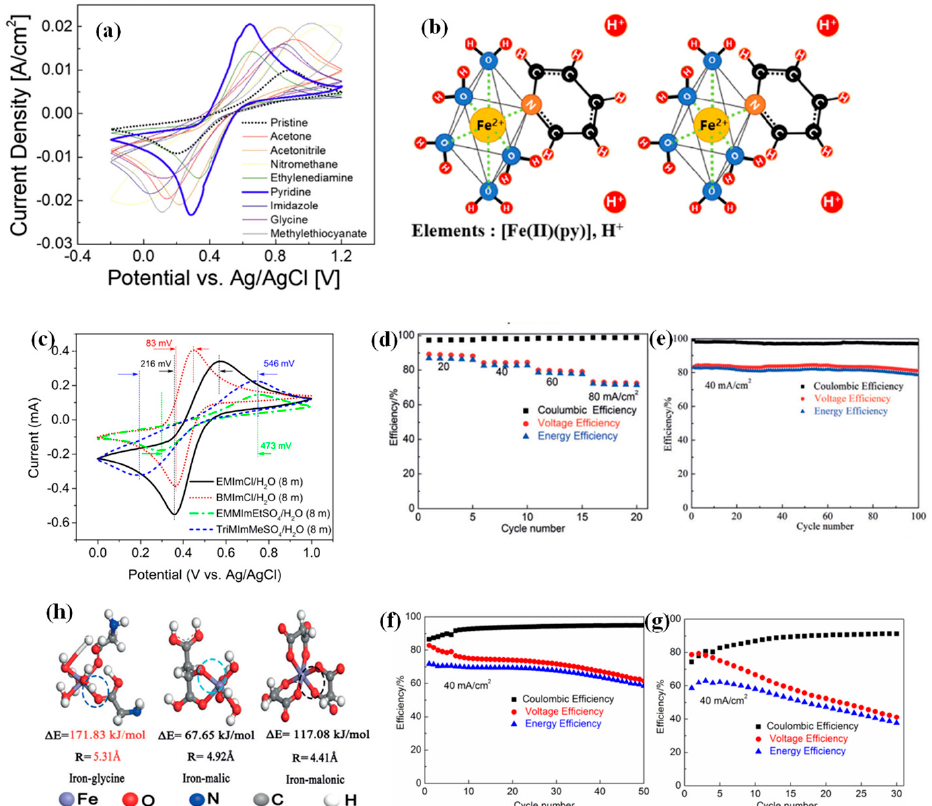
Figure 12. ( a ) CV curves comparison of Fe 2+ complexing ligands at the scanning rate of 30 mV s − 1 (20 cycles average); ( b ) Fe 2+ -pyridine complex forms as a result of the molar ratio when pH < 2; reproduced with permission from [82]. Copyright 2020, Elsevier. ( c ) CV curves of 50 mM FeCl 2 in different aqueous ionic liquid solutions; reproduced with permission from [99]. Copyright 2019, Elsevier. Cycling performance of the battery with glycine ( d , e ), malic acid ( f ), malonic acid ( g ); ( h ) theoretical calculations of radii and bond energies. Reproduced with permission from [44]. Copy-